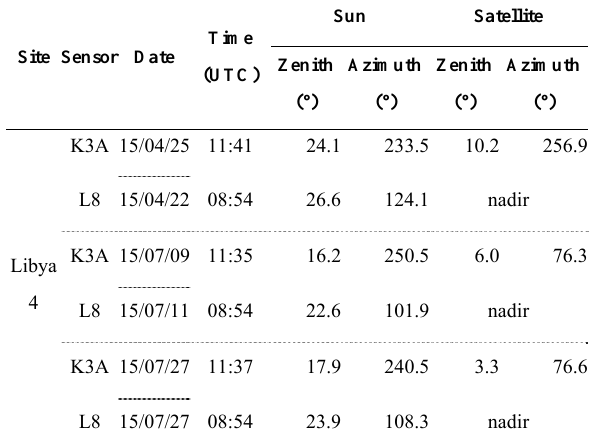
Table 1. Metadata of images in this study